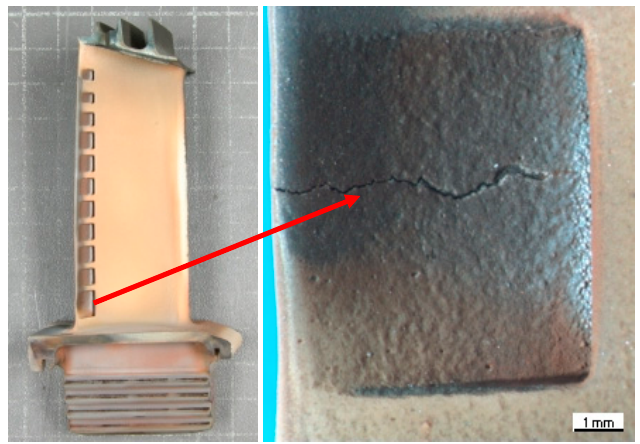
Figure 5. Tear in turbine blade.